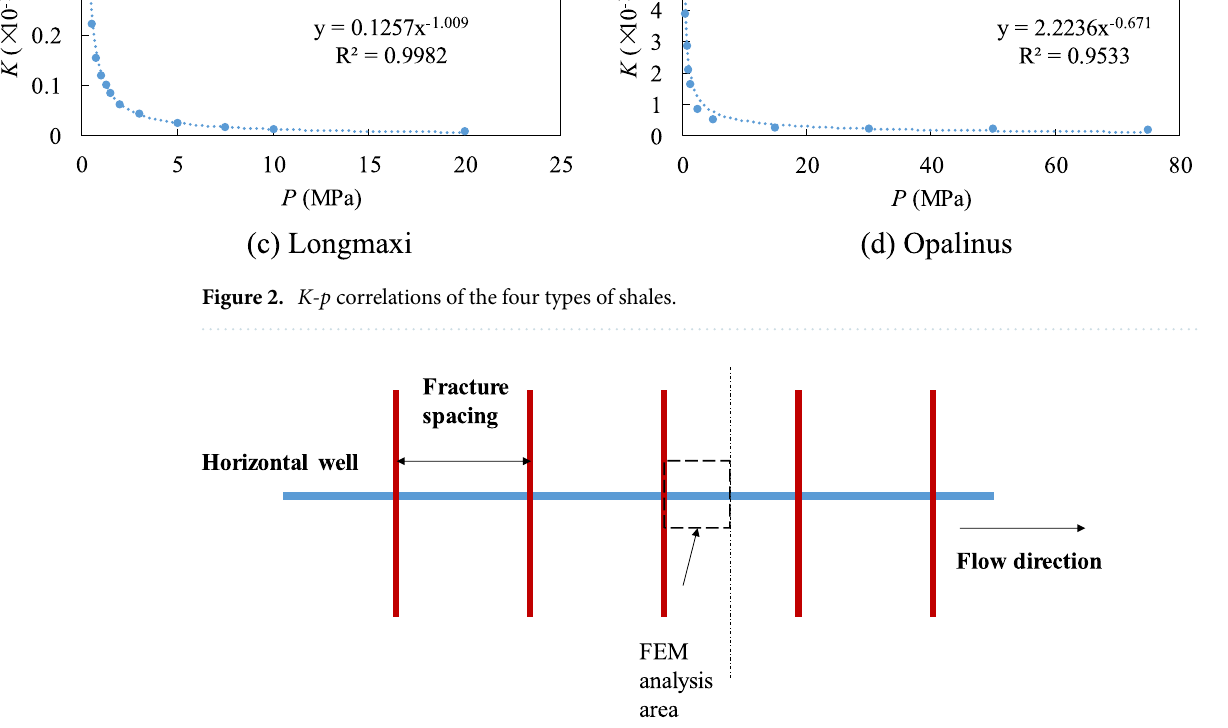
Figure 3. Schematic diagram of the horizontal well and fractures.